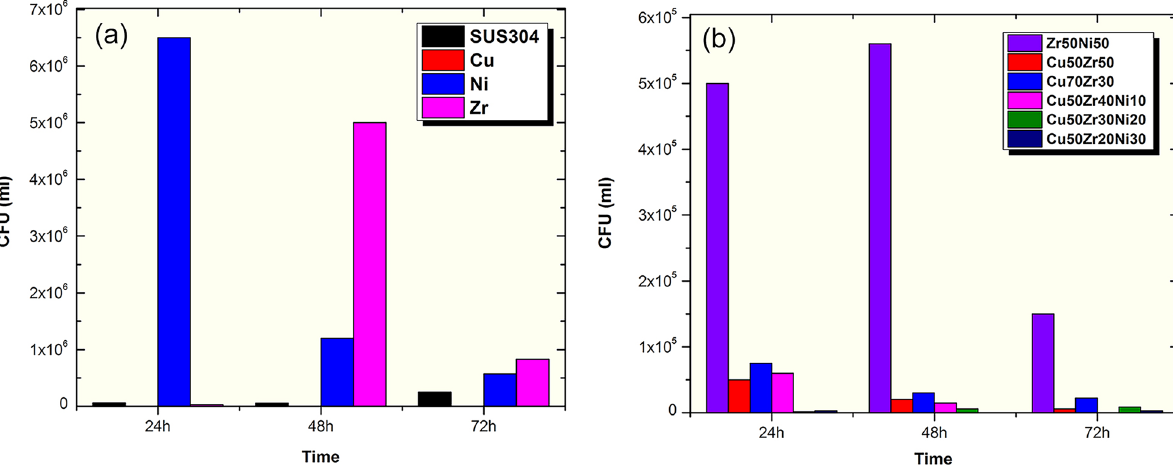
Figure 17. Inhibition of biofilm adhesion on ( a ) uncoated SUS304 coupons, and elemental Cu, Ni, and Zr metals, ( b ) binary Zr 50 Ni 50 , Cu 50 Zr 50 , and Cu 70 Zr 30 systems. The results for inhibition of biofilm adhesion of selected ternary Cu 50 (Zr 50−x Ni x ) systems (x; 10, 20, 30 at.%) are displayed in ( b ). E. coli (ATCC 25922) biofilm viable counts were enumerated at different time points (24, 48 and 72 h) from tested coating alloy (13b) or control coated and non-coated coupons (13a). Biofilm formed by E.coli (ATCC 25922) was significantly inhibited by ternary systems (CuZrNi) at all times points tested in comparison to control coated coupons. Results represents mean ± SD of 3 independent